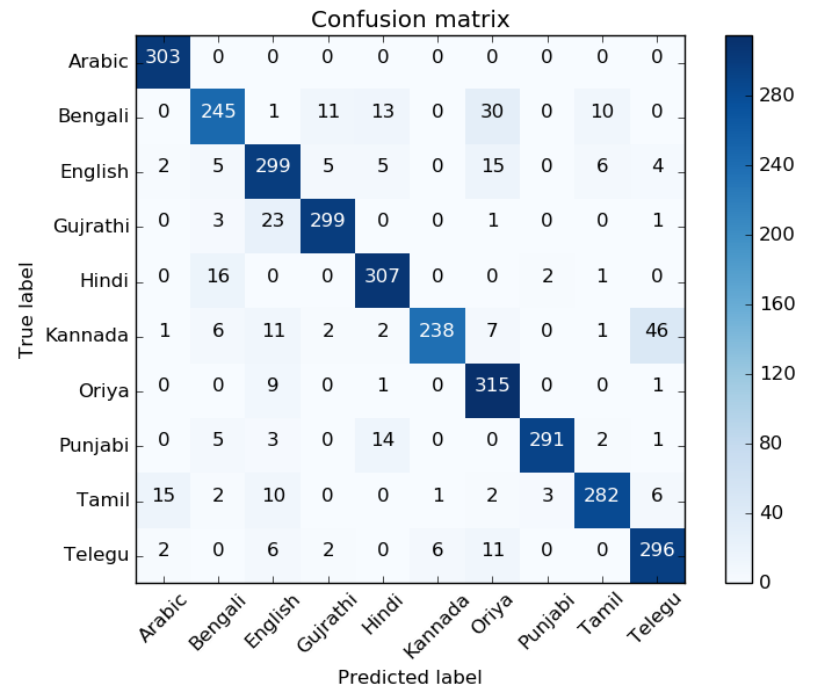
Figure 8. Confusion matrix on CVSI-15 dataset using VGG-16 fine-tune model with Adam optimizer.